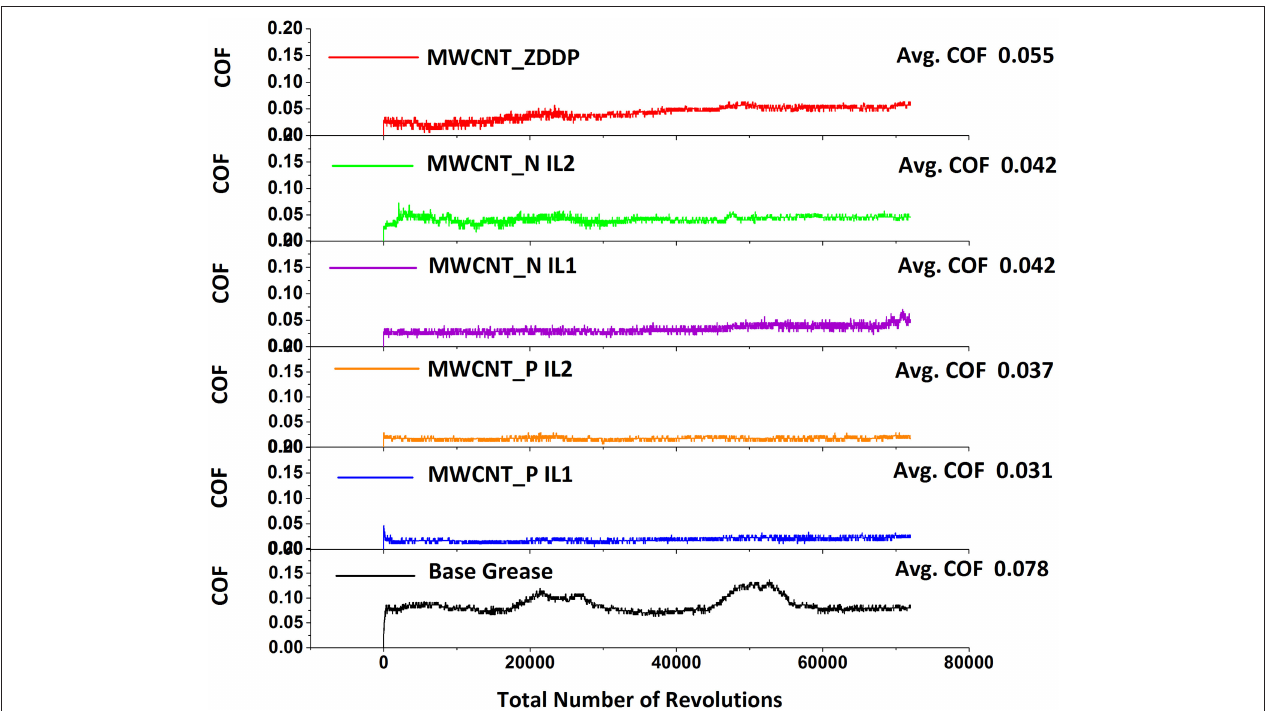
FIGURE 6 | Coefficient of friction outcomes from four ball wear tests for greases with MWCNT and ILs additives compared with base grease and MWCNT_ZDDP grease